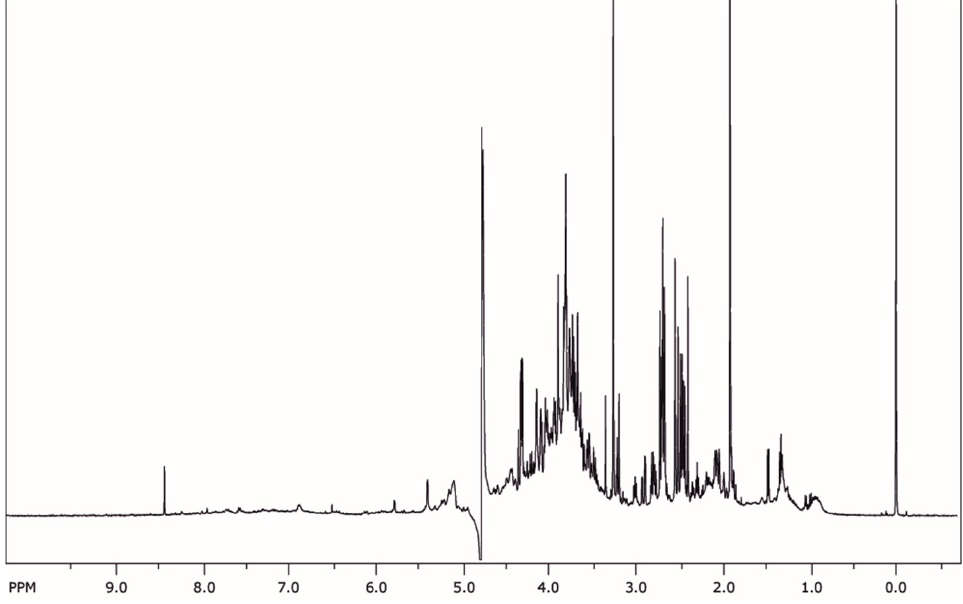
Figure 1. 1 H NMR fingerprint of the extract prepared from Urtica dioica